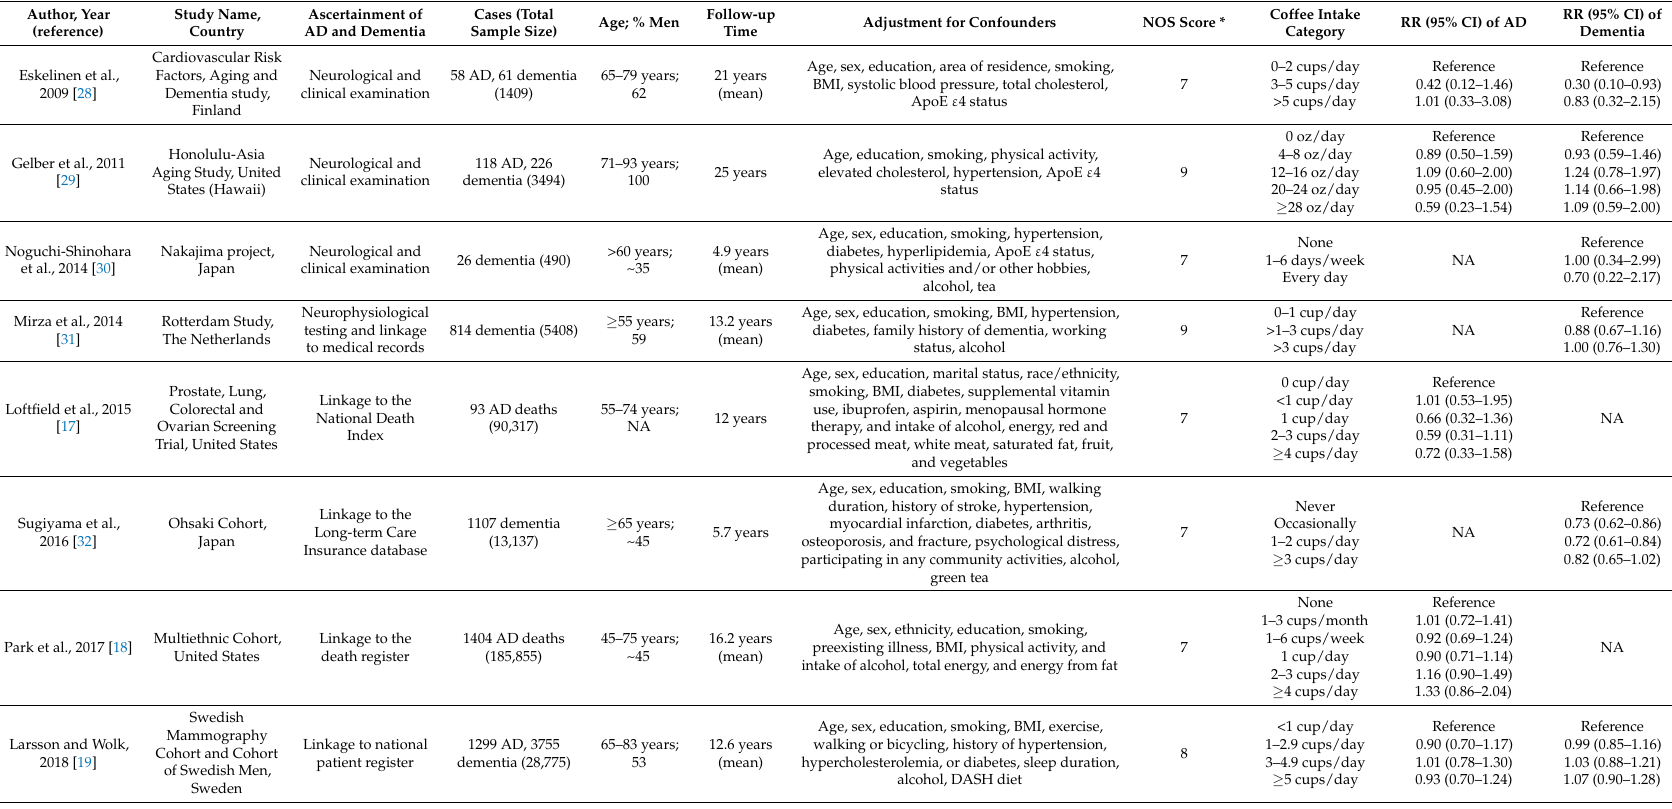
Table 1. Prospective studies of coffee consumption and risk of Alzheimer’s disease and all-cause